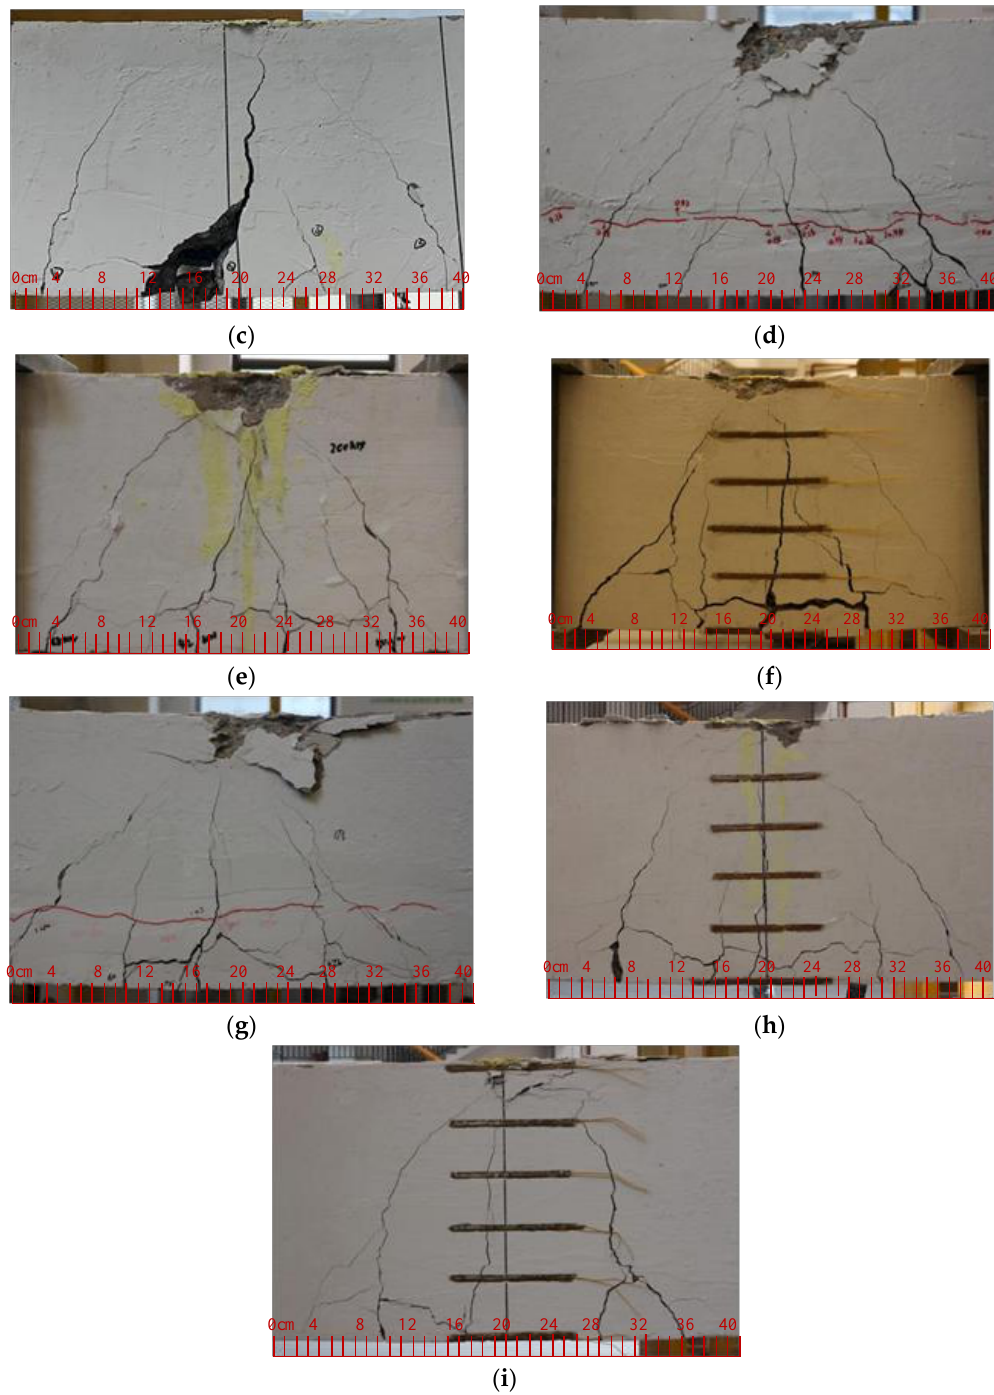
Figure 10. Failure modes of the test beams: ( a ) Steel-S, ( b ) SFCB-S, ( c ) CFRP-S, ( d ) SFCB-RE, ( e ) SFCB-UP, ( f ) SFCB-CP, ( g ) CFRP-RE, ( h ) CFRP-UP, ( i ) CFRP-CP.